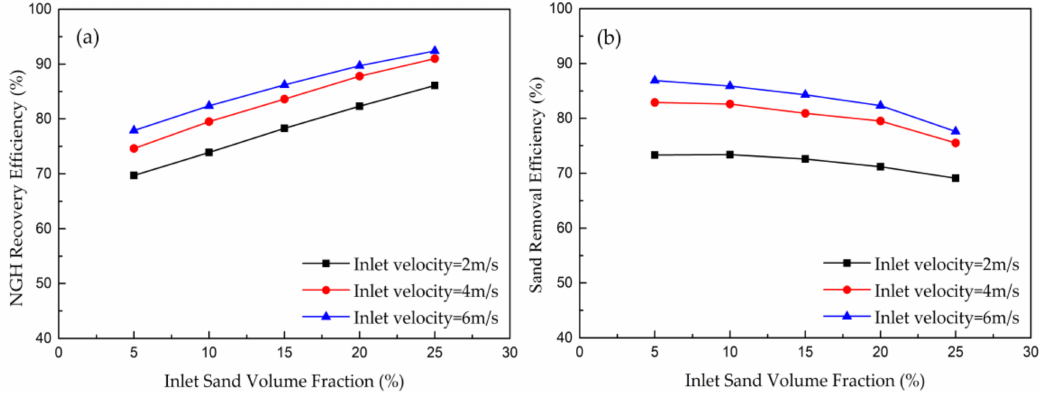
Figure 15. The relationship between inlet sand volume fraction and e ffi ciency: ( a ) is for NGH, ( b ) is for sand). On the other side, when inlet velocity increases, the NGH recovery e ffi ciency and sand removal e ffi ciency increase continuously. The main reasons are that the increase of inlet velocity increases the centrifugal force, so that the probability of hydrate migration to the center and sand migration to wall increase. Therefore, increasing the inlet velocity is helpful to the recovery of NGH and sand removal.